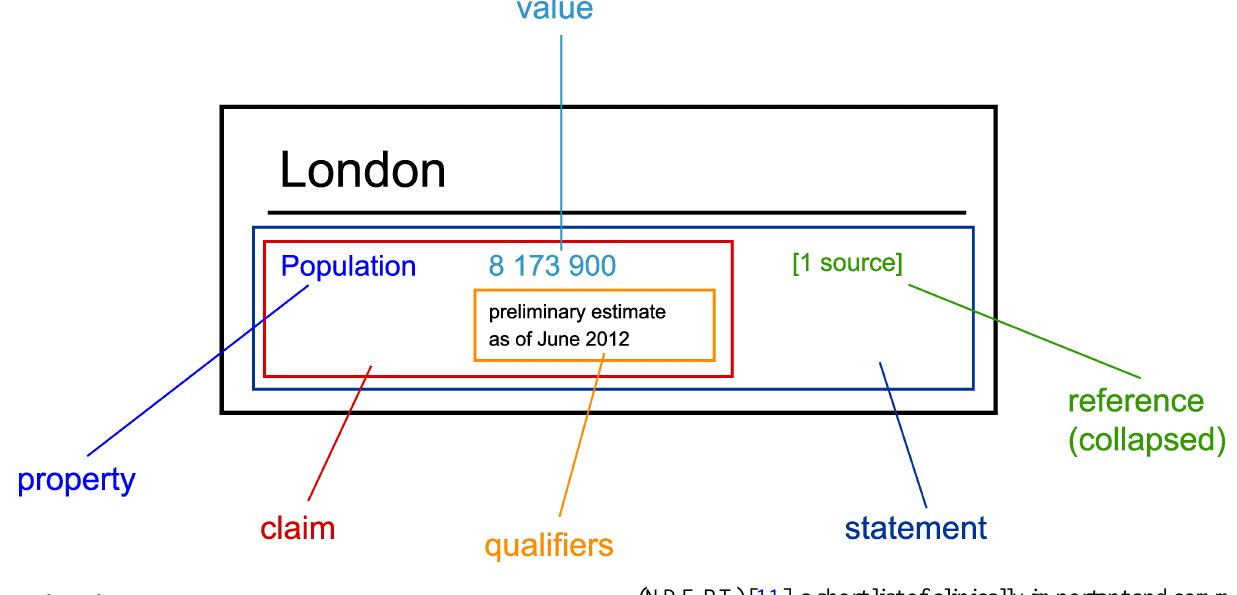
Figure 1. The structure of a statement in Wikidata. Source: